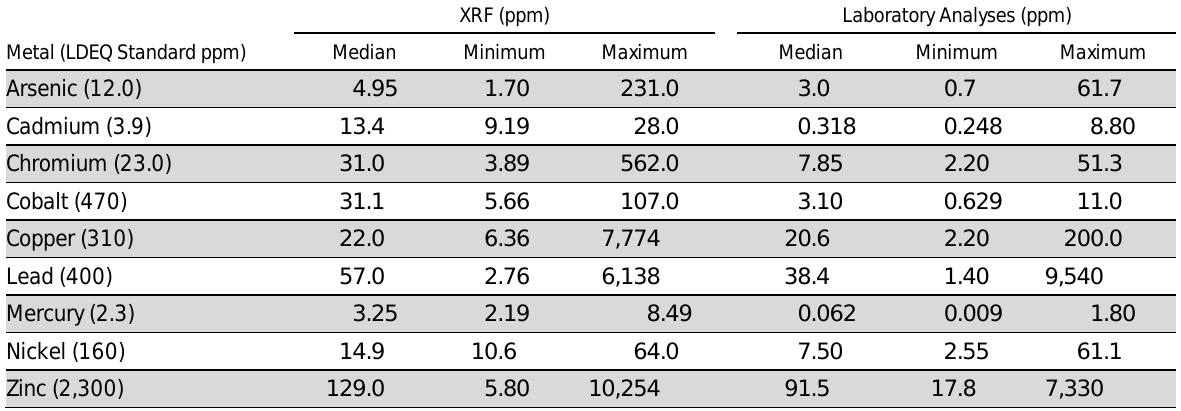
Table 1. Summary Statistics of Metals Analyzed by XRF and Laboratory Analyses